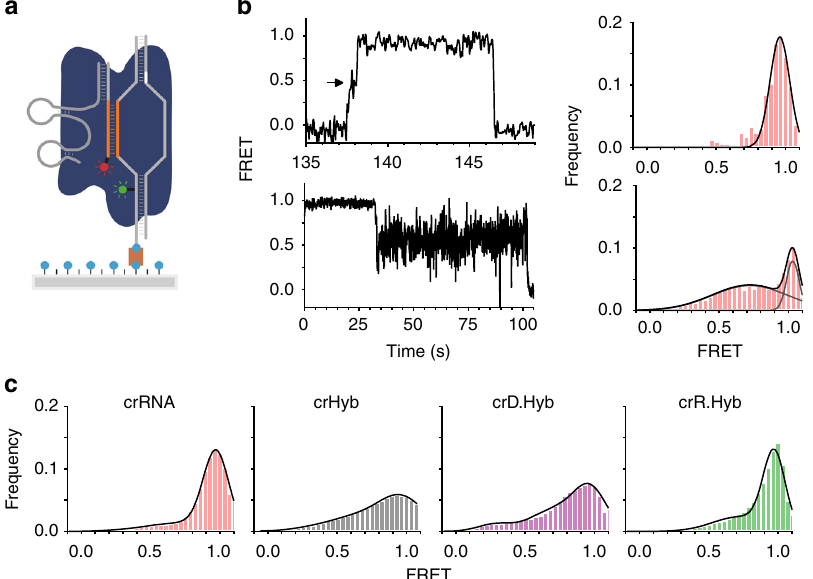
Fig. 4 Conformational dynamics of target-bound dCas9:trRNA:crXNA complexes. a Single-molecule FRET experimental design. Surface-immobilised Cy3-labelled (green) DNA containing the AAVS1 target site (orange) and PAM site (white) binds Cy5-labelled (red) dCas9 complex (blue) to yield a FRET signal. b Representative single-molecule FRET trajectories show dCas9 – crRNA complex binding in heteroduplex conformation as an increase to high FRET (top) through a transient intermediate (arrow). Irreversible conformational change into a dynamic intermediate FRET state (bottom). Corresponding time-binned FRET histograms (right), and Gaussian fi ts (black curves). Trajectories are 5 point averaged. c Time-binned FRET histograms for each guide: crRNA (red, n = 91); crHyb (grey, n = 57); crD.Hyb (magenta, n = 197), and crR.Hyb (green, n =